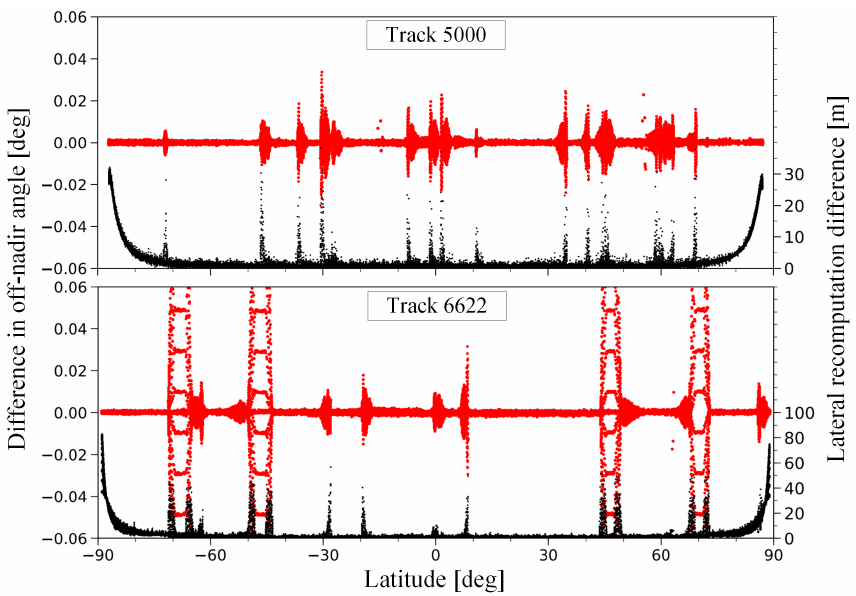
Figure 9. Comparison of the footprint off-nadir angles between that retrieved using the NAIF CK kernels and that documented in the PEDR dataset for ground track 5000 (nadir; ( top )) and 6622 (off- nadir; ( bottom )). Shown for comparison are these two tracks’ lateral differences in the recomputation experiments, as in Section